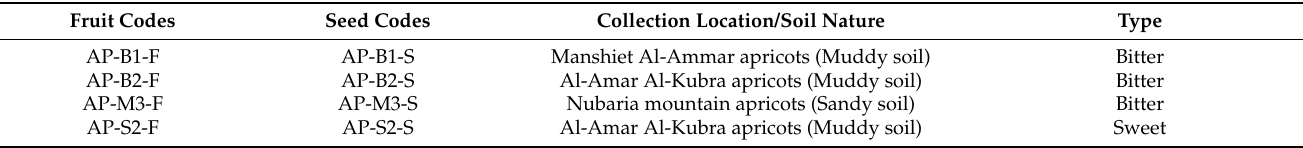
Table 1. Origin of the different apricot fruits and seed kernels used in this